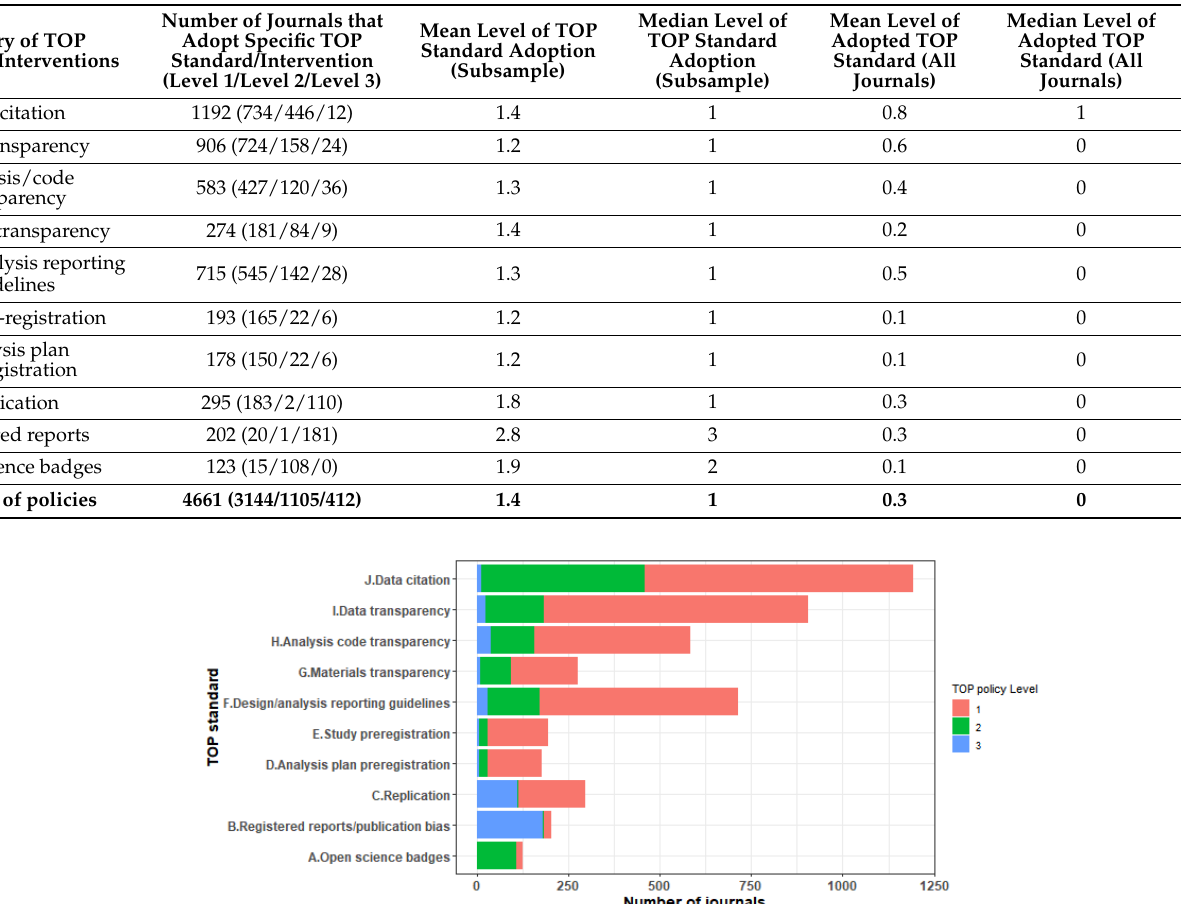
( b ) Figure 2. Overview of the adoption of TOP standards across 2000 journal policies from the TOP Factor metric. ( a ) Pie chart that shows the number of journals that implement at least one TOP standard: No-indicates journals that do not implement TOP standards (N = 455, TOP Factor = 0), Yes-indicates a number of journals that implement at least one TOP standard (N = 1545, TOP Factor > 0). ( b ) Histogram of the number of journals that adopt one or more TOP standards. An individual journal can adopt up to eight TOP standards, however, two additional interventions-“Open Science badges” and “Registered Reports”-were added to the standards for this plot. Thus, category 10 corresponds to journals that adopt all 8 standards and 2 interventions. The high proportion of journals adopted four different standards (N = 337); 74% of which correspond to the adoption of “Data citation”, “Data transparency”, “Analysis code transparency” and “Design analysis reporting guidelines” standards (N = 245, Supplementary Table S5). A total of 78 journals adopt all eight TOP standards, whereas